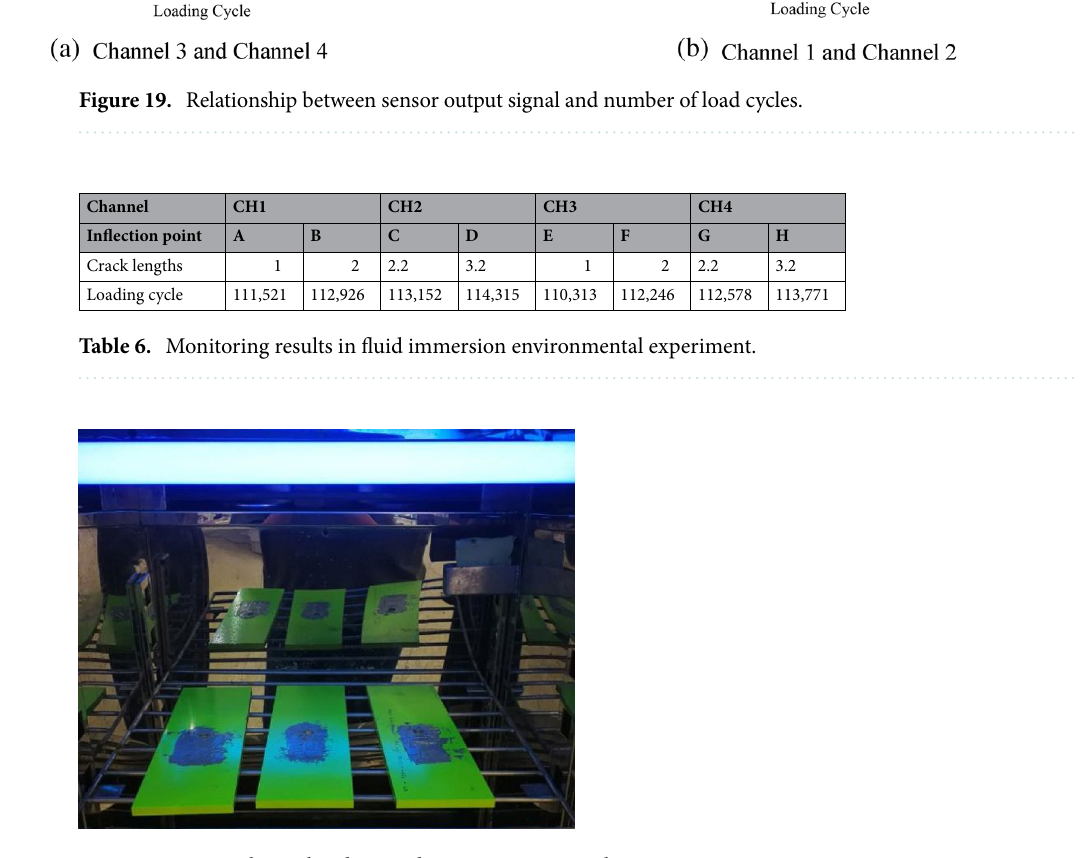
Figure 20. Hygrothermal and UV radiation environmental experiment.